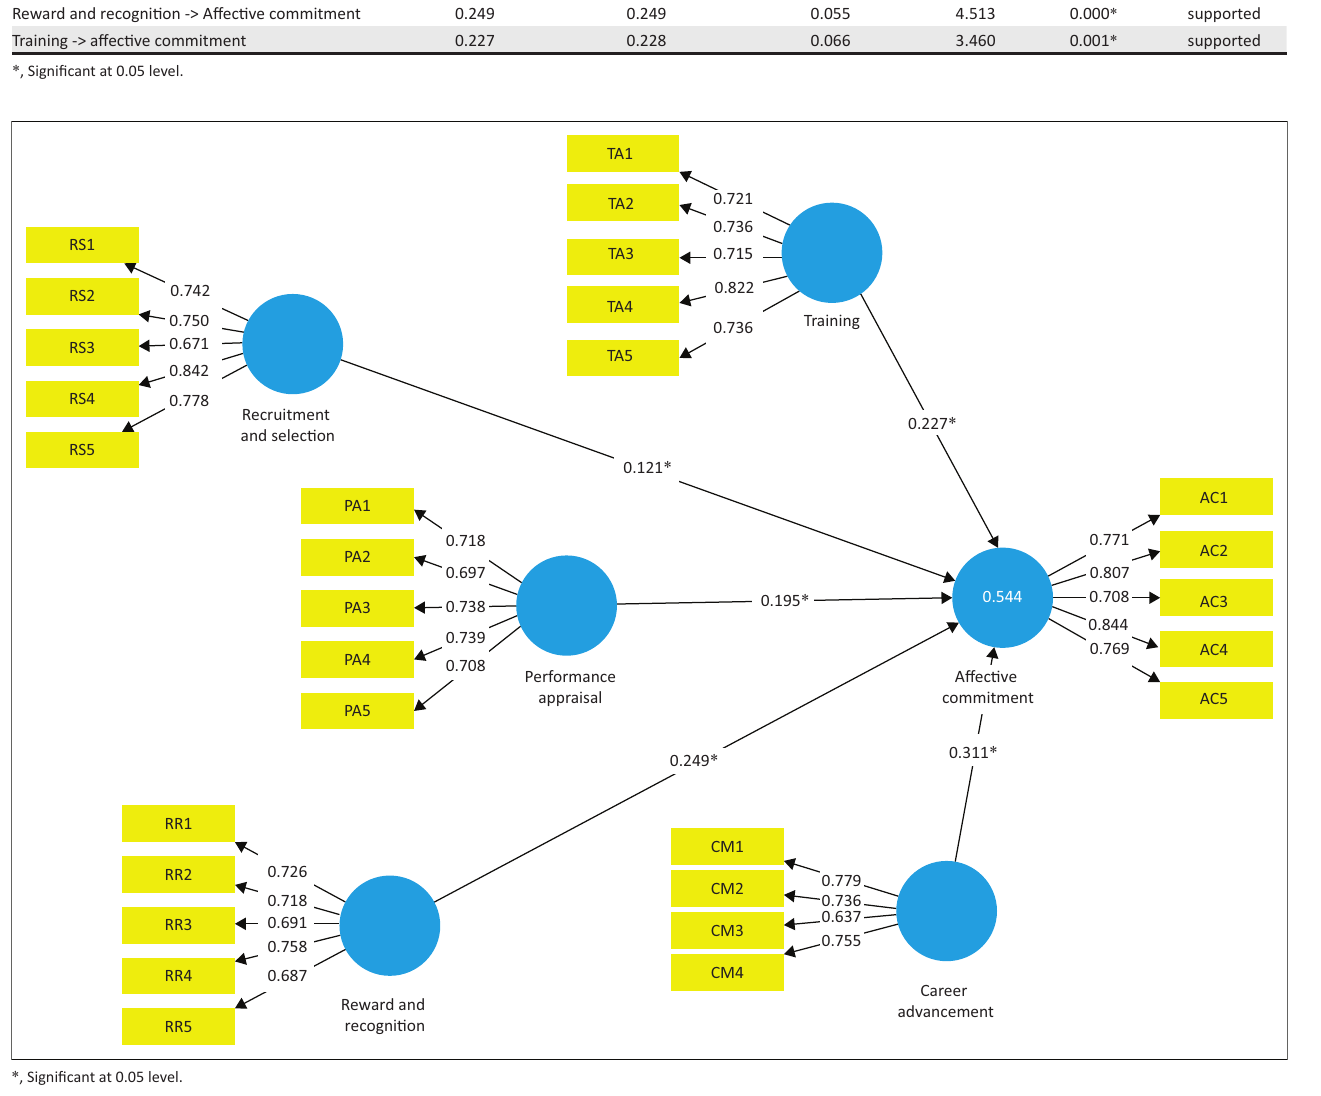
FIGURE 1: Structural equation model.